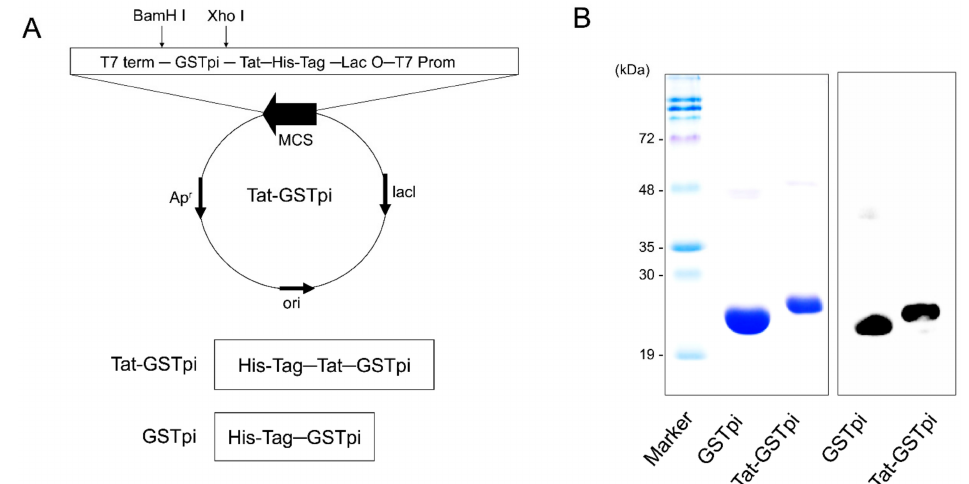
Figure 1. Construction and purification of Tat-GSTpi protein. ( A ) Schematic sequence of Tat-GSTpi and GSTpi protein. Tat-GSTpi protein consists of six histidine, Tat peptide, and cDNA of human GSTpi; ( B ) Purification of Tat-GSTpi and GSTpi proteins were analyzed by SDS-PAGE and Western blotting with an anti-histidine antibody.